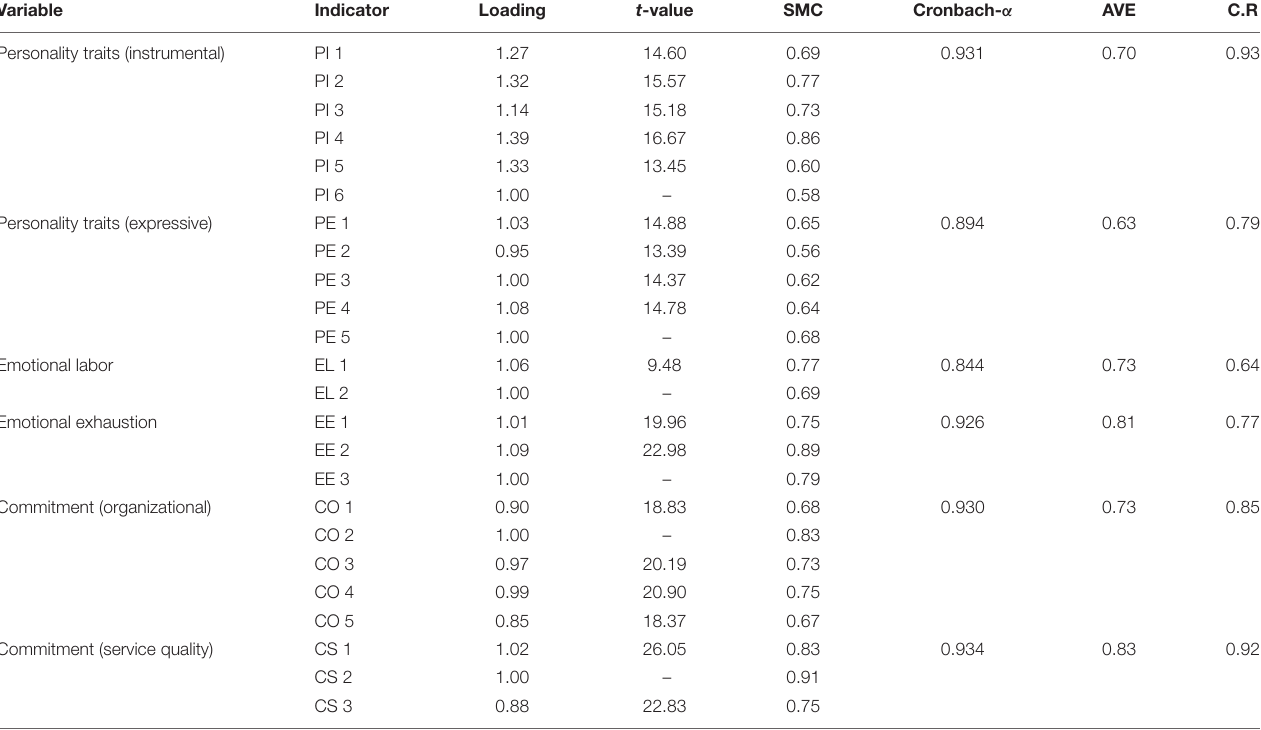
TABLE 3 | Reliability and validity tests.